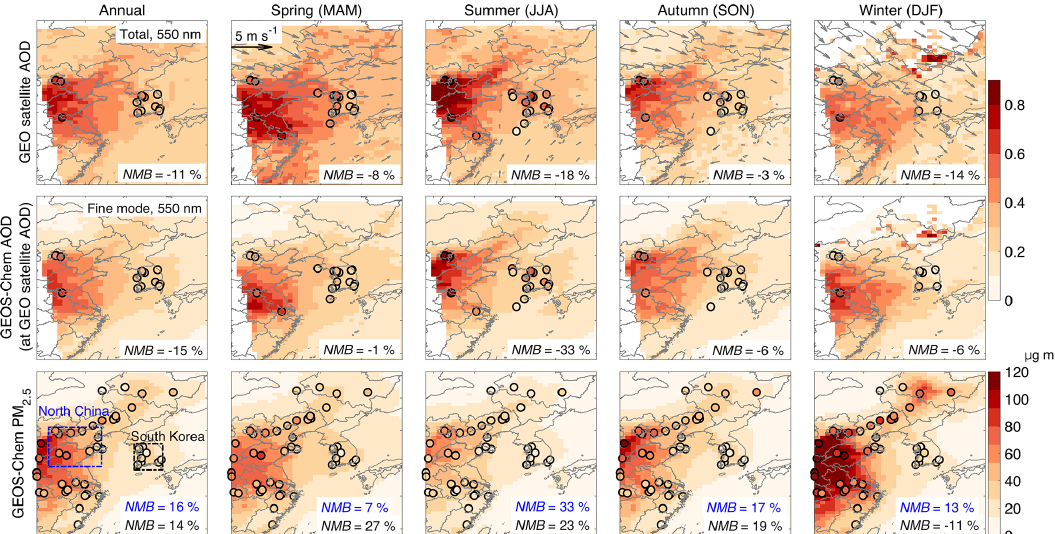
Figure 6. Spatial distributions of 2016 annual and seasonal mean AOD (550nm) and surface PM 2 . 5 . The top row shows the observed GOCI– AHI geostationary satellite AOD (GEO satellite AOD) on the GEOS-Chem 0 . 5 ◦ × 0 . 625 ◦ grid with superimposed 925hPa GEOS-FP wind fields and AERONET total AODs (circles). The middle row shows clear-sky GEOS-Chem AOD, with AERONET fine-mode AOD added as circles. The bottom row shows GEOS-Chem surface PM 2 . 5 (background) with surface network measurements (circles). AERONET AODs are shown only when more than 10 months of data are available for the annual mean, and all 3 months of data are available for each season. The PM 2 . 5 observations shown are for a random selection of 7% of network sites for visual clarity. GEOS-Chem PM 2 . 5 is calculated at 35% RH (Table 3). Normalized mean biases (NMBs) inset are for the comparisons of GEO satellite and GEOS-Chem values to the corresponding ground measurements.